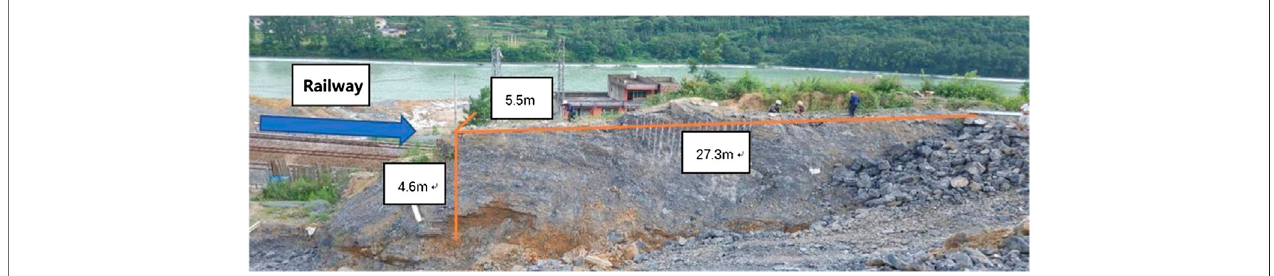
FIGURE 8 | Rock wall site for demolition blasting